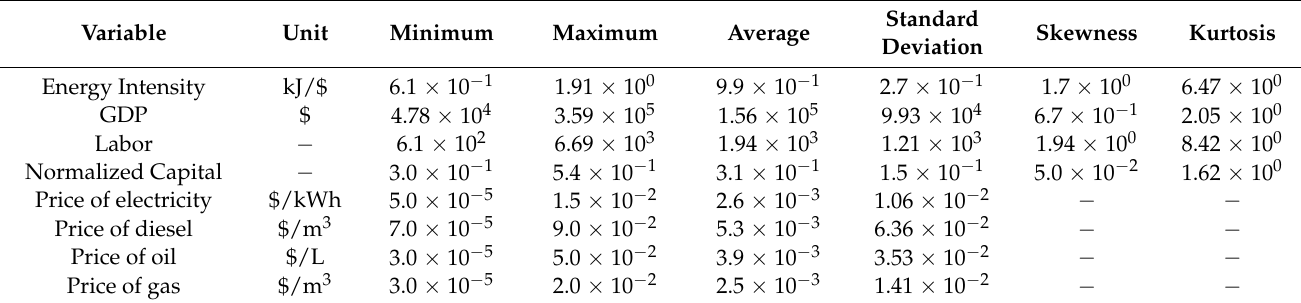
Table 1. Statistical characteristics of the studied